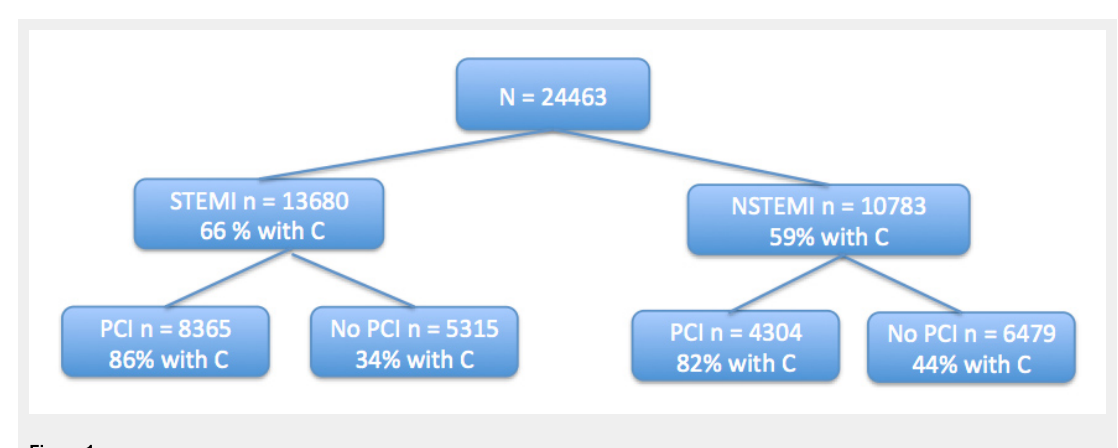
Flow chart of the patient regarding STEMJ, NSTEMJ and PCI or no PCI and wpercentage of patients treated with clopidogrel ( C ).